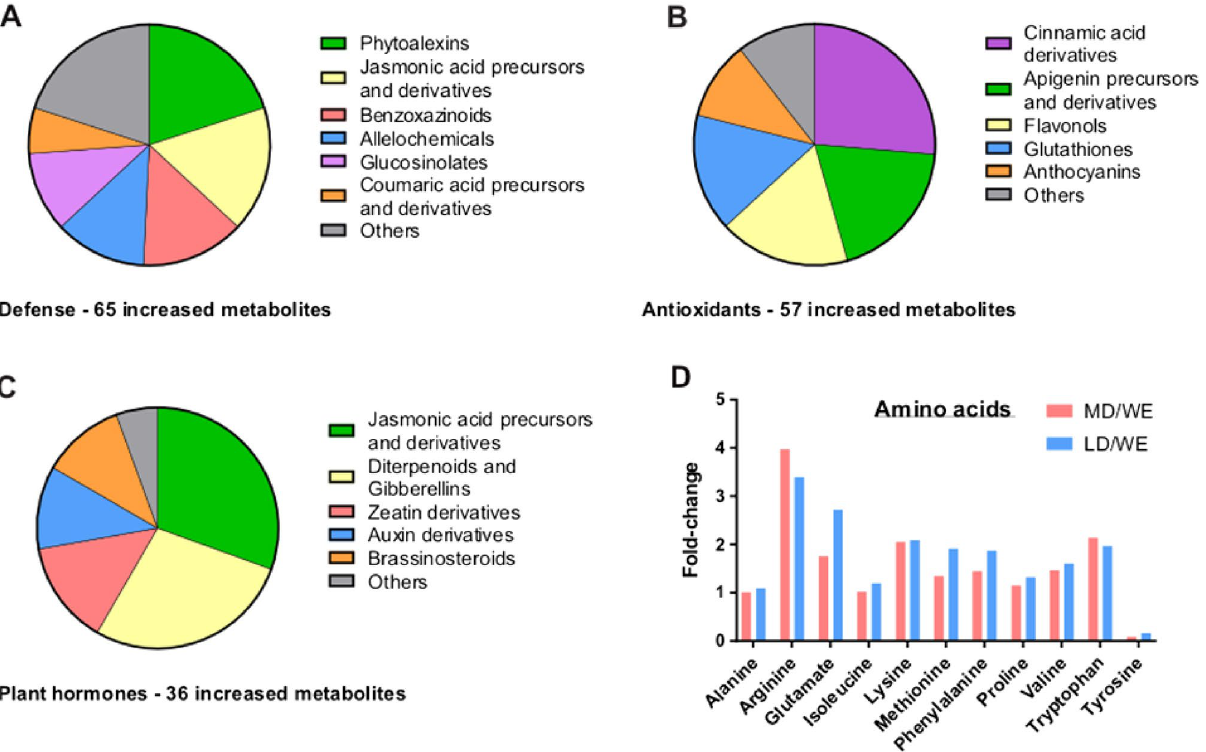
Figure 3. Categories of biological function. Embryo metabolomes. Identified metabolites that underwent a significant increase in association with wheat domestication (WE to LD and MD) were classified according to chemical structure and biological function. ( A ) Metabolites that are involved in plant defense mechanisms. ( B ) Metabolites that are known to be antioxidants. ( C ) Plant hormones and their intermediates. ( D ) Proteinogenic amino